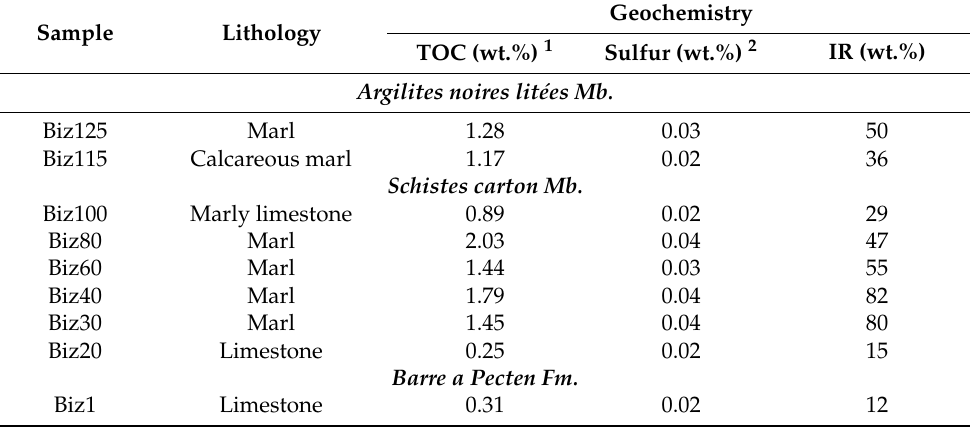
Table 1. Geochemical data from the Bizanet section.